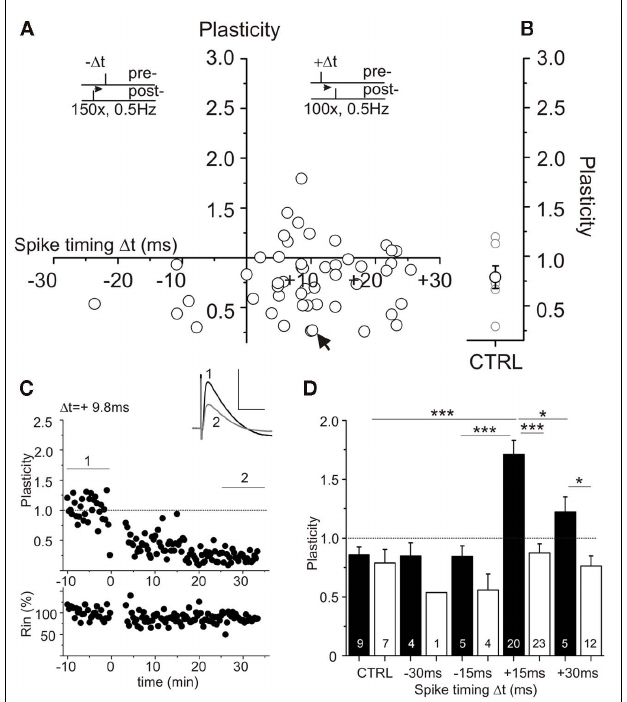
FIGURE 2 | Spike timing-dependent plasticity (STDP) after sucrose preparation of rat hippocampal slices reveals STDP deficiency. Experimental conditions as in Figure 1 , but slices were prepared in sucrose media. (A) Neither positive nor negative pairings led to convincing levels of STDP (compare Figure 1 ). STDP paradigms with single EPSP/AP pairings are indicated by insets. (B) Level of plasticity in control experiments in sucrose prepared slices without spike pairing (open circle: n = 7, mean ± SEM). (C) Example of an experiment with positive pairing in a sucrose prepared slice. Averaged original traces are shown in the inset, recording of input resistance is shown in the lower graph.The corresponding cell is marked with an arrow in (A) . Bar scale: 1mV, 50ms. (D) Summary of STDP results in ACSF (black) and sucrose (white) prepared hippocampal slices at different spike timings (in ms, 15ms binning). Data are given as mean ± SEM; statistics were performed by ANOVA * p < 0.05; *** p < 0.0001.